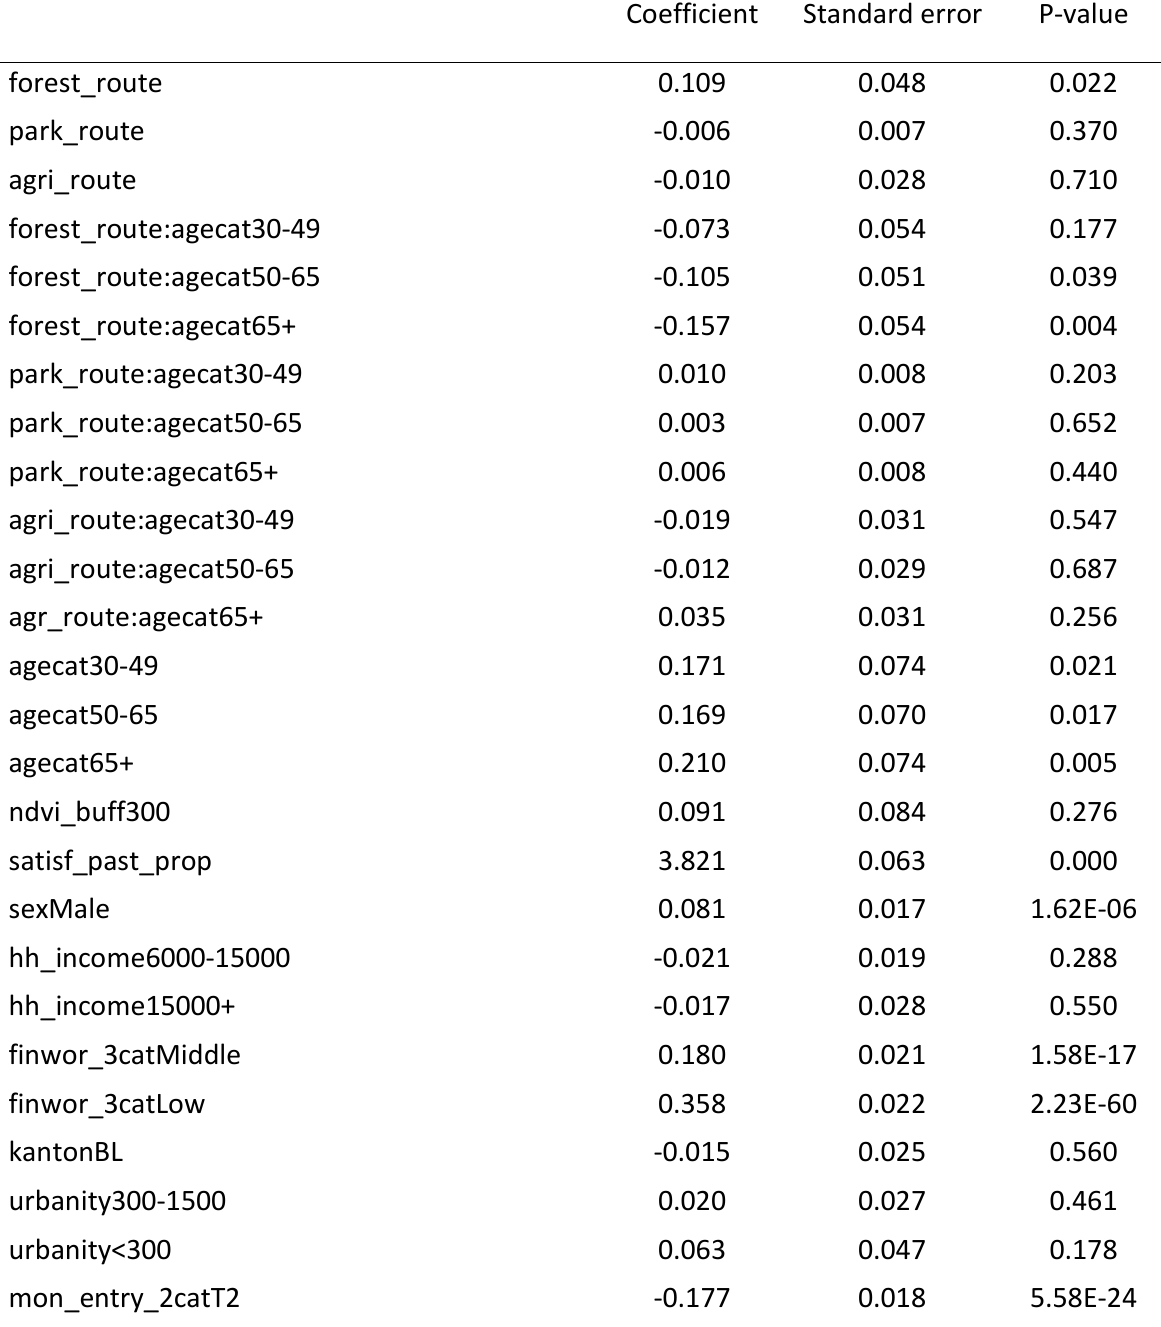
Table S3 . Results from Beta regression of life satisfaction on proximity to greenspace (a) by age categories, (b) by household income, (c) by financial worries, adjusted for life satisfaction in the past, age categories, sex, household income, financial worries, canton, degree of urbanisation, month of entry, and NDVI (a) Moderation by age categories (likelihood ratio test p-value =